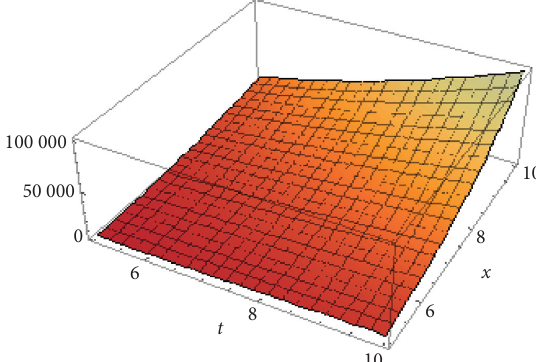
Figure 3: 3D plot of equation (73) for c � 0 . 50 ; β � 0 . 25 ; y � 1.